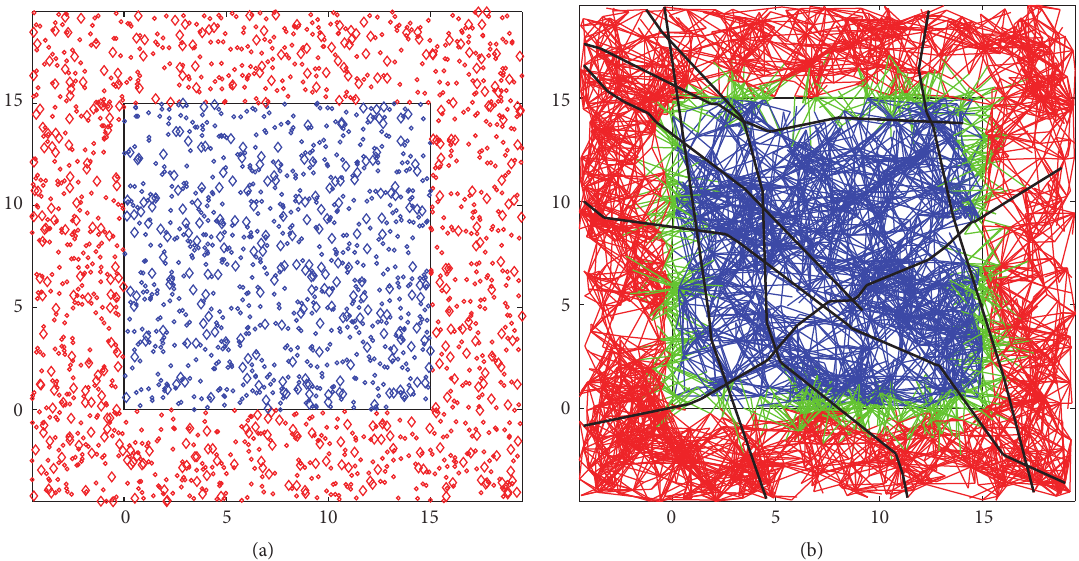
Figure 1: Discrete square space 24 × 24 MHD. Central study region 15 × 15 MHD is referred to as the “box.” Nodes and dendrites lie inside the box (blue) or outside the box (red) or across the boundary (green). (a) Source and target nodes for mesh generation. (b) Definition of dendrites and addition of CNTs (shown in black